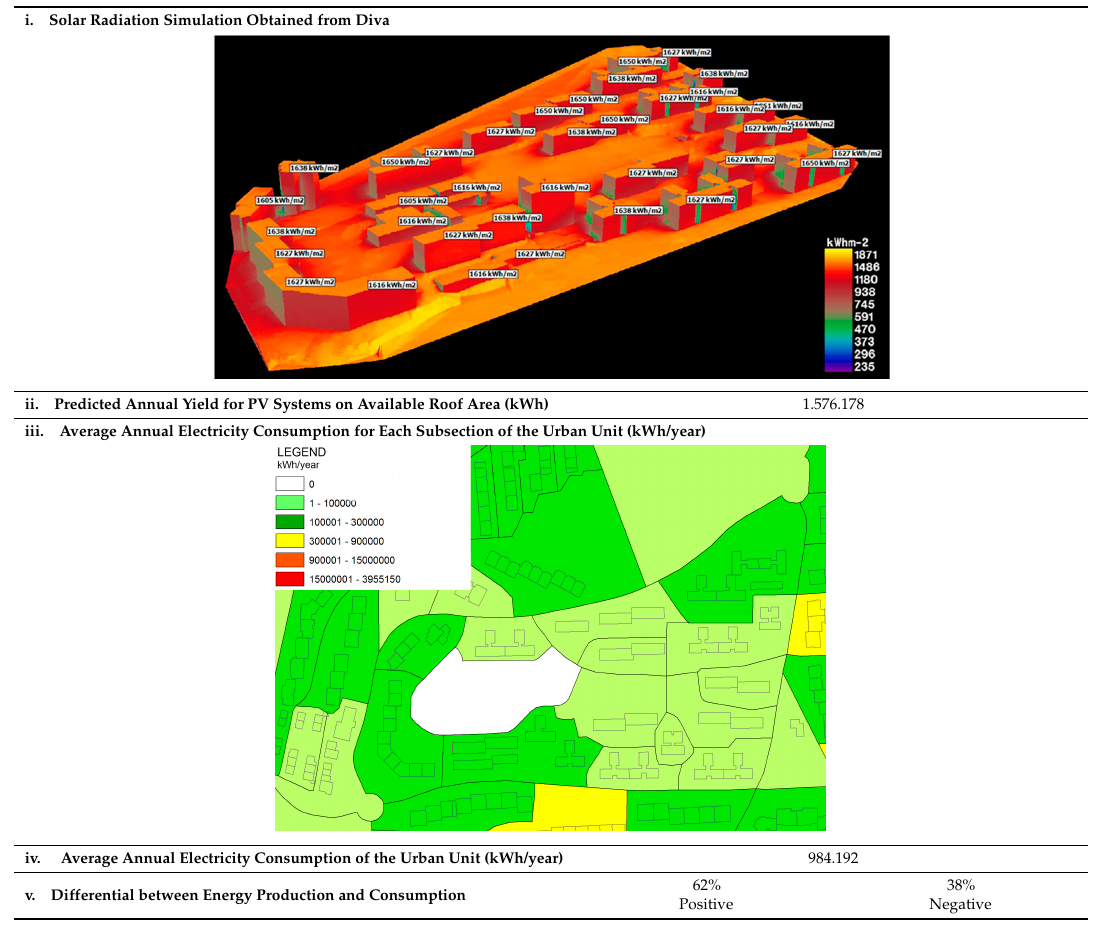
Table 4. Urban unit energy performances.